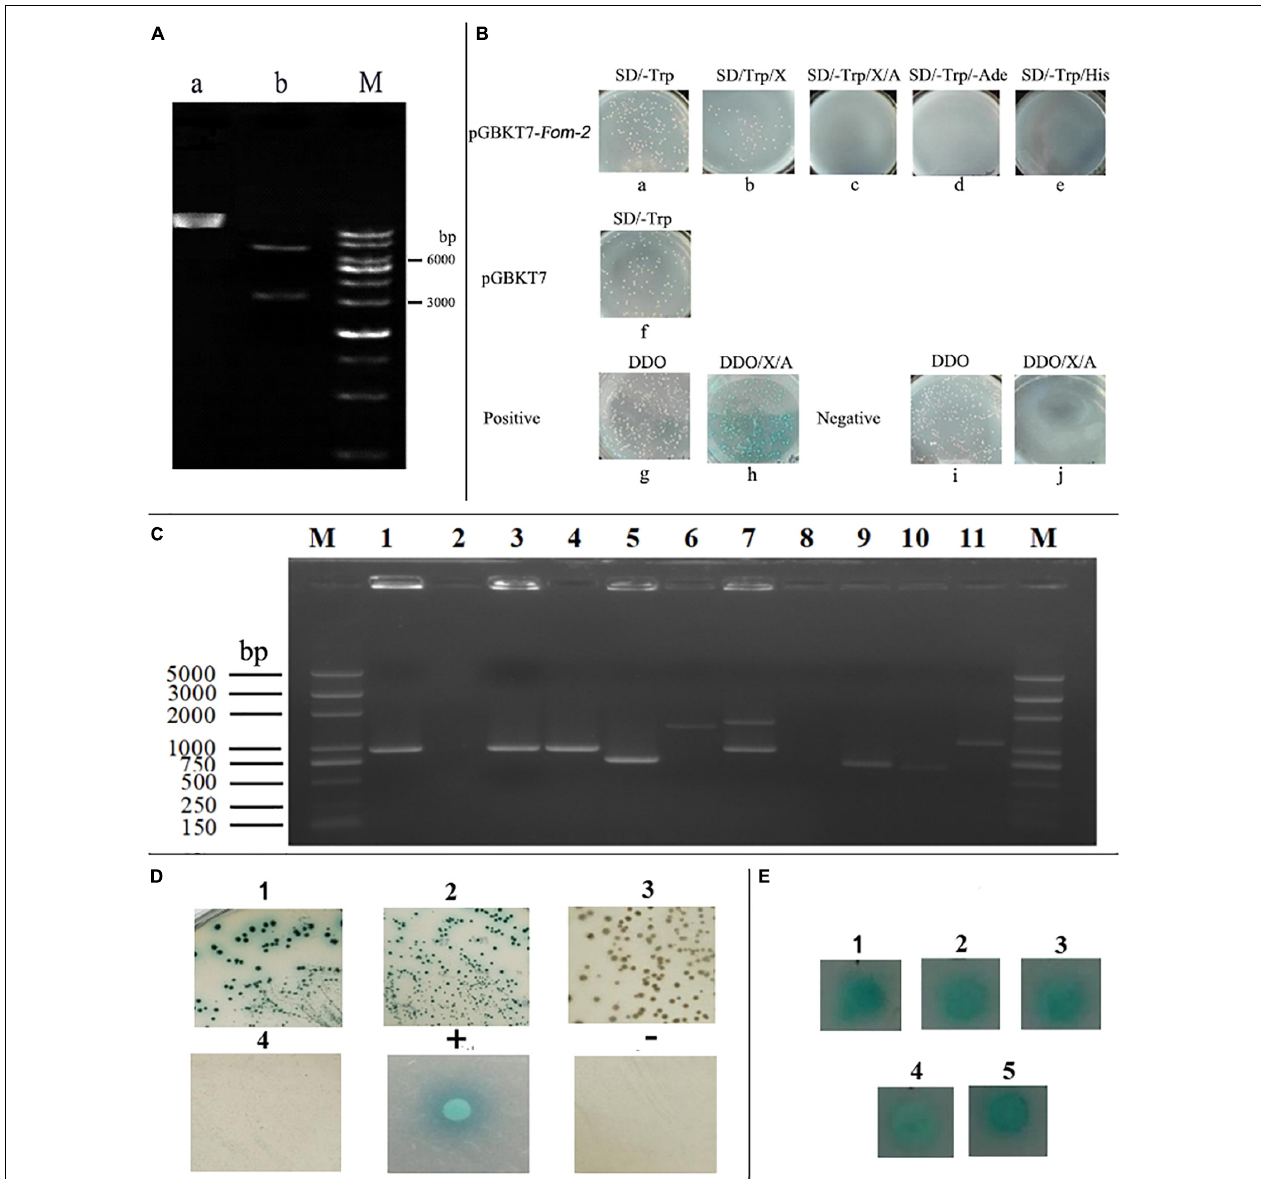
FIGURE 6 | Construction, self-activation, and toxicity identification of Fom-2 decoy protein. (A) a: pGBKT7- Fom -2, b: A double digestion product of pGBKT7- Fom -2 and M: 1kb ladder Marker. (B) Detection of auto-activation and toxicity of bait plasmid pGBKT7- Fom -2, Positive: Y2HGold (pGBKT7-53) × Y187 (pGADT7-T), Negative: Y2HGold (pGBKT7-Lam) × Y187 (pGADT7-T). (C) Hypothesized positive clones were inserted into yeast plasmid for PCR analysis, M:D2000 plus marker. (D) Interaction was identified by co-transformation of positive clone plasmid, 1: pGBKT7/bait + Candidate prey on DDO/X, 2: pGBKT7/bait + Candidate prey on QDO/X/A, 3: empty pGBKT7 + Candidate prey on DDO/X, 4: empty PGBKT7 + Candidate prey on QDO/X/A, + : positive control on QDO/X/A, − : negative control on QDO/X/A. (E) 1–5 Candidate protein mating verifies on